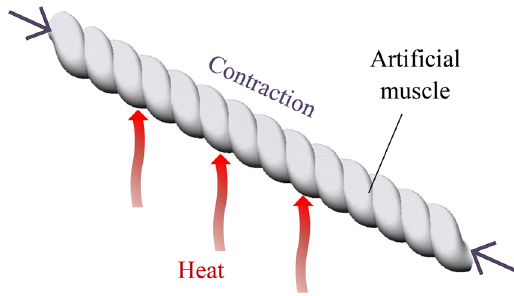
Figure 1: A schematic of carbon nanotube yarn muscle contraction.